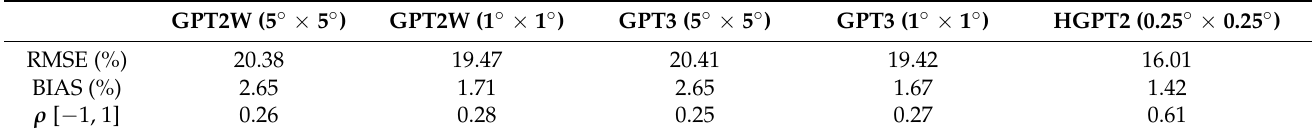
Figure 6. Comparison of 1 year (2020) of ERA5 PWV (calculated by ECMWF) with HGPT2 PWV; ( a ) mean RMSE values (in mm); ( b ) mean bias values, positive (negative) values indicate an overestimation (underestimation) of the HGPT2 model (in mm); ( c ) mean Pearson correlation coefficient values; and ( d ) mean RMSE values obtained by comparing 5 years of MODIS monthly data and HGPT2 estimates. Table 1. Mean RMSE, bias, and correlation coefficient ( ρ ) for GPT2w, GPT3 (two grid resolution), and HGPT2, calculated using 282 met-files with RH observations for 1 year (2020), hourly